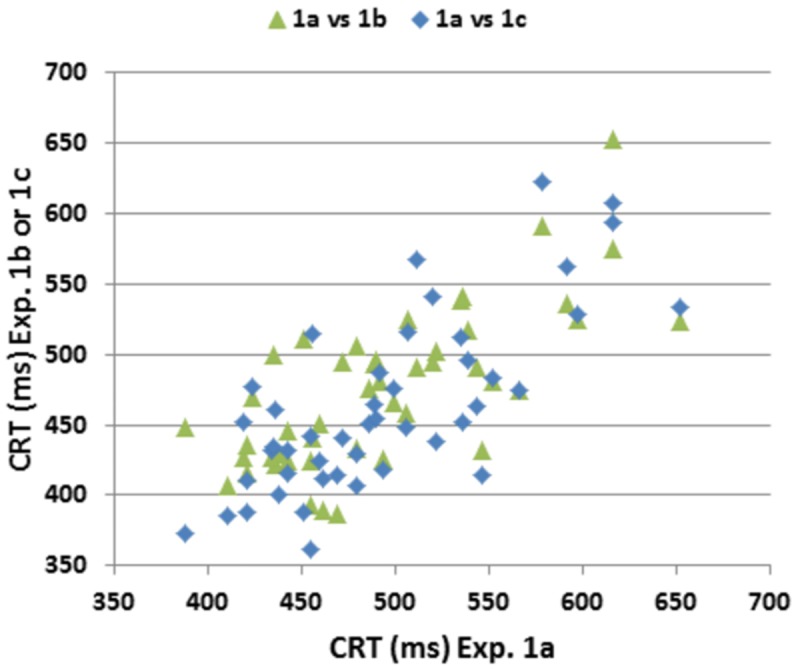
Test–retest reliability of CRTs. CRTs in Experiment 1a plotted against CRTs in Experiments 1B,C. Pearson correlations across repeated tests were 0.72 (Experiment 1A vs. Experiment 1B), 0.74 (Experiment 1A vs. Experiment 1C) and 0.77 (Experiment 1B vs. Experiment 1C).